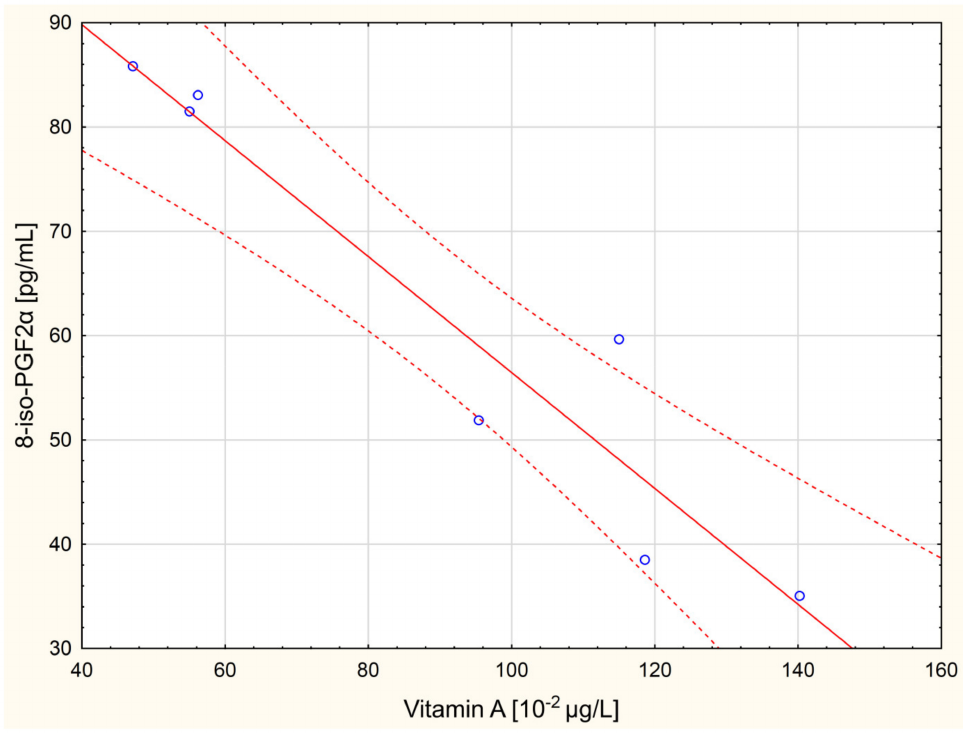
Figure 1. Linear correlation between the concentrations of vitamin A and 8-iso-prostaglandin F2 α in serum of venous blood in women with ovarian cancer ( r = − 0.99, p = 0.012).